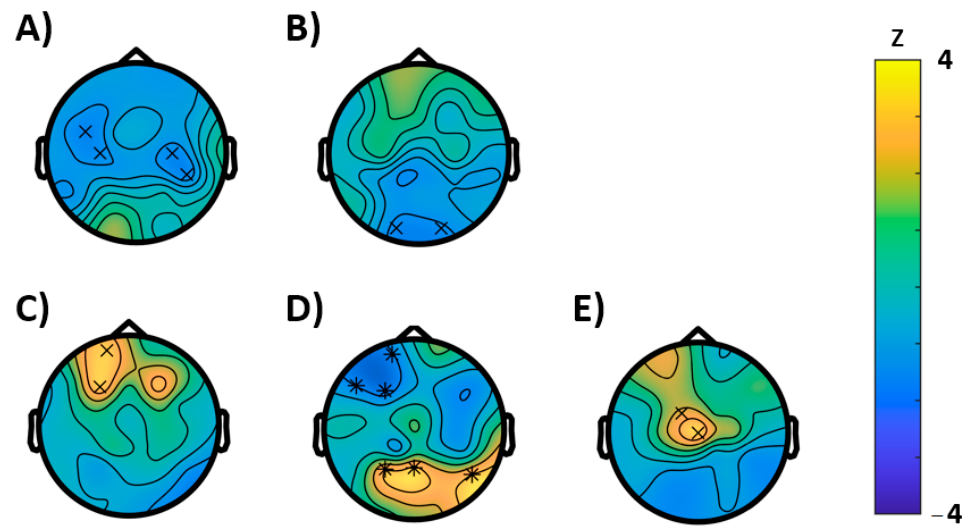
Figure 3. Results of the cluster based permutation tests (BASELINE vs. MONTELUKAST, cluster corrected, x = p < 0.05, * = p < 0.01). ( A ) Rest 1, entropy; ( B ) WP-task recall, Hjorth activity; ( C – E ) VR-task: ( C ) brain-rate, ( D ) entropy, and ( E ) Hjorth activity.